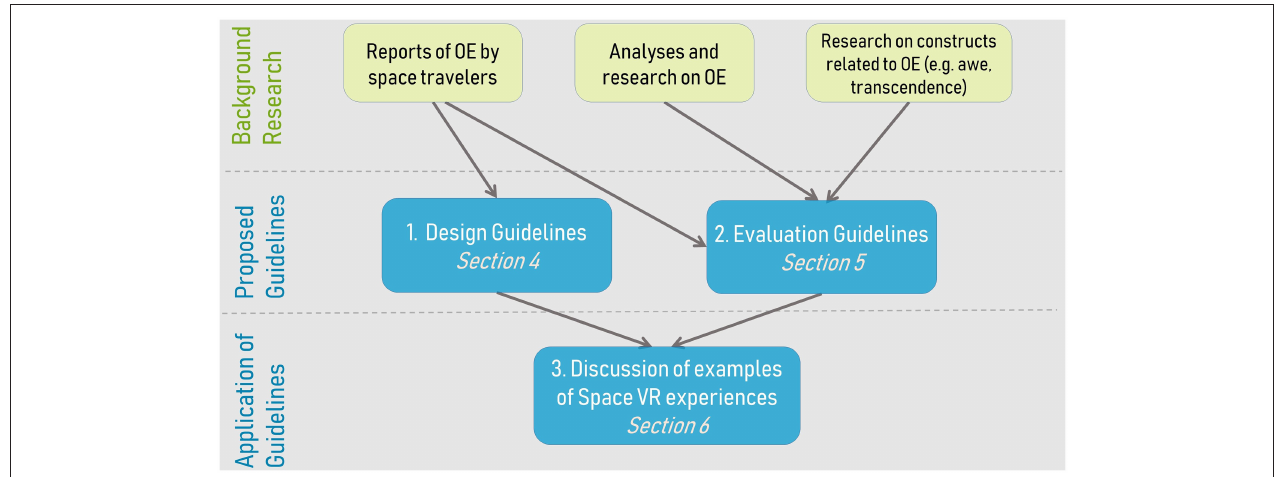
FIGURE 1 | The diagram illustrating the general structure of the current paper and its